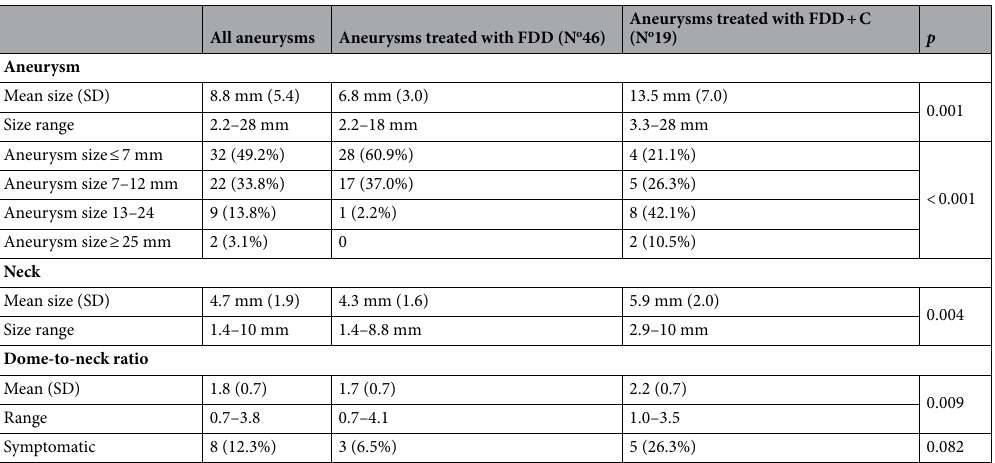
Table 1. Aneurysm characteristics in whole group and subgroups, according to the treatment technique. FDD, flow diverting device alone; FDD+C, flow diverting device with coiling; SD,–standard